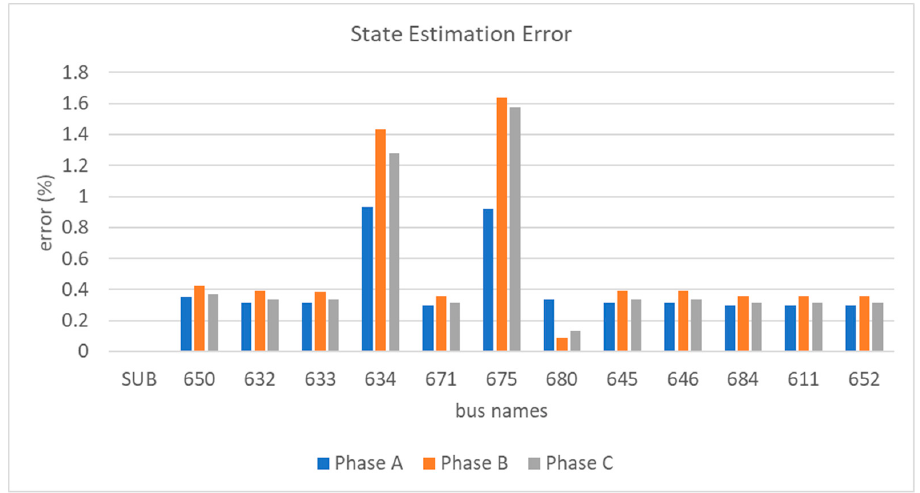
Figure 7. Voltage magnitude error in 13-bus distribution network for the first loading condition.